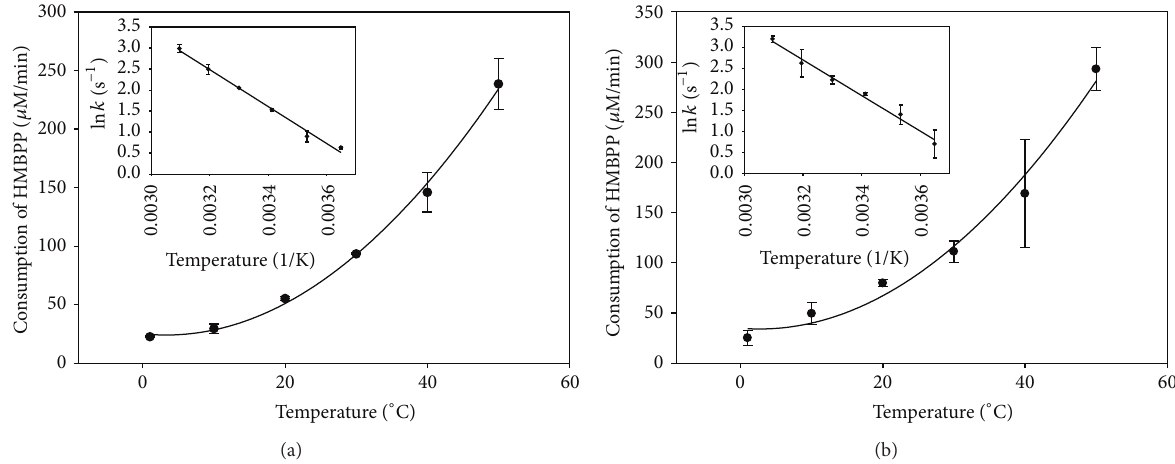
Figure 4: Temperature-dependent activity profiles of GbIspH1-full (a) and GbIspH1-truncated (b) with the Arrhenius plot